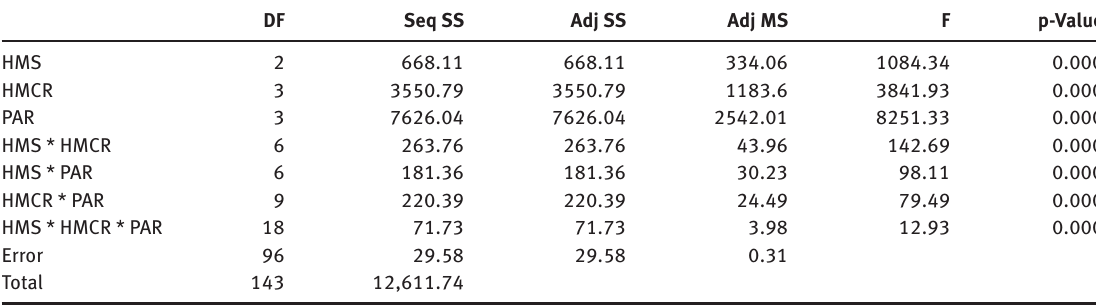
Table 5: Analysis of Variance on HSA.